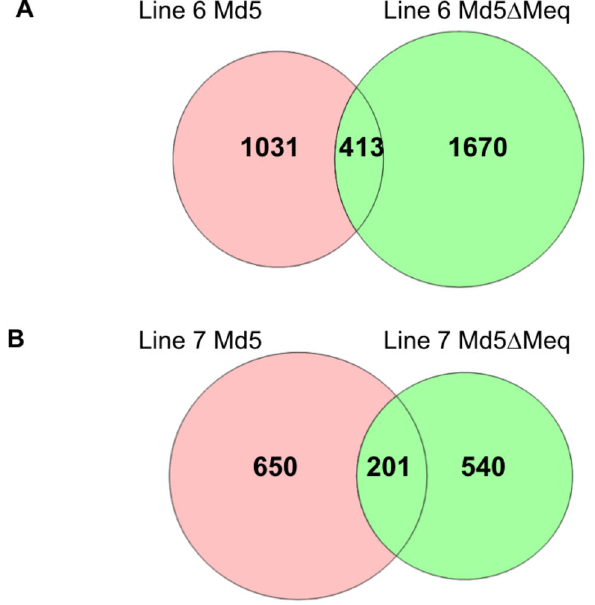
Figure 2. Identification of Meq-dependent genes in MD resistant or susceptible chicken lines. Venn diagram of comparison between two virus-infected groups in line 6 and line 7. Each circle depicts the number of differentially expressed genes compared to uninfected controls. The portion highlighted in pink in each diagram denotes the Meq- dependent genes.